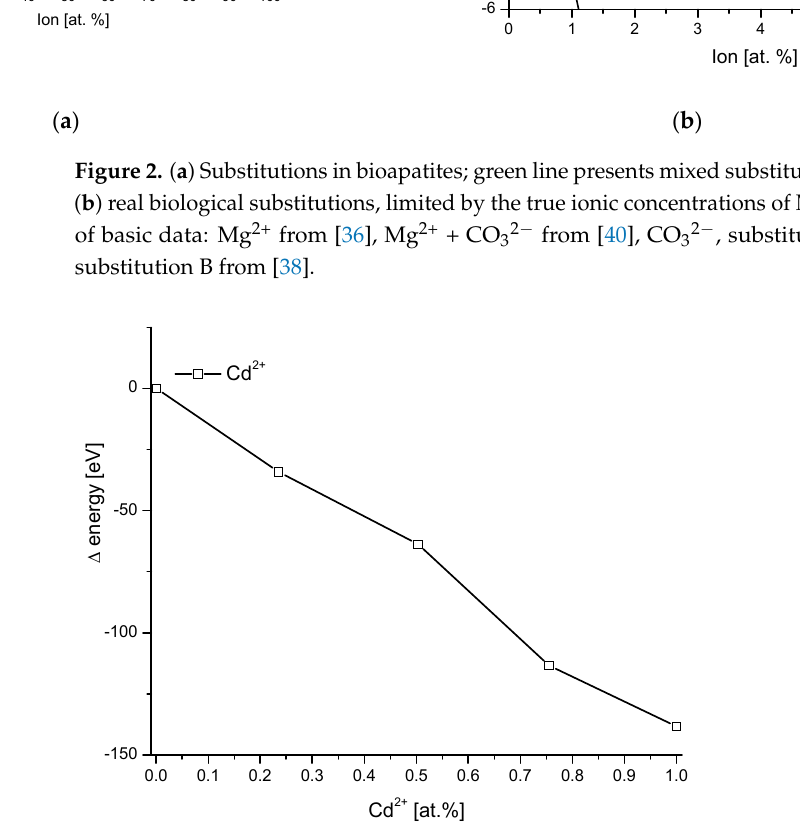
Figure 3. Substitution of Cd into hydroxyapatite, data from [42].